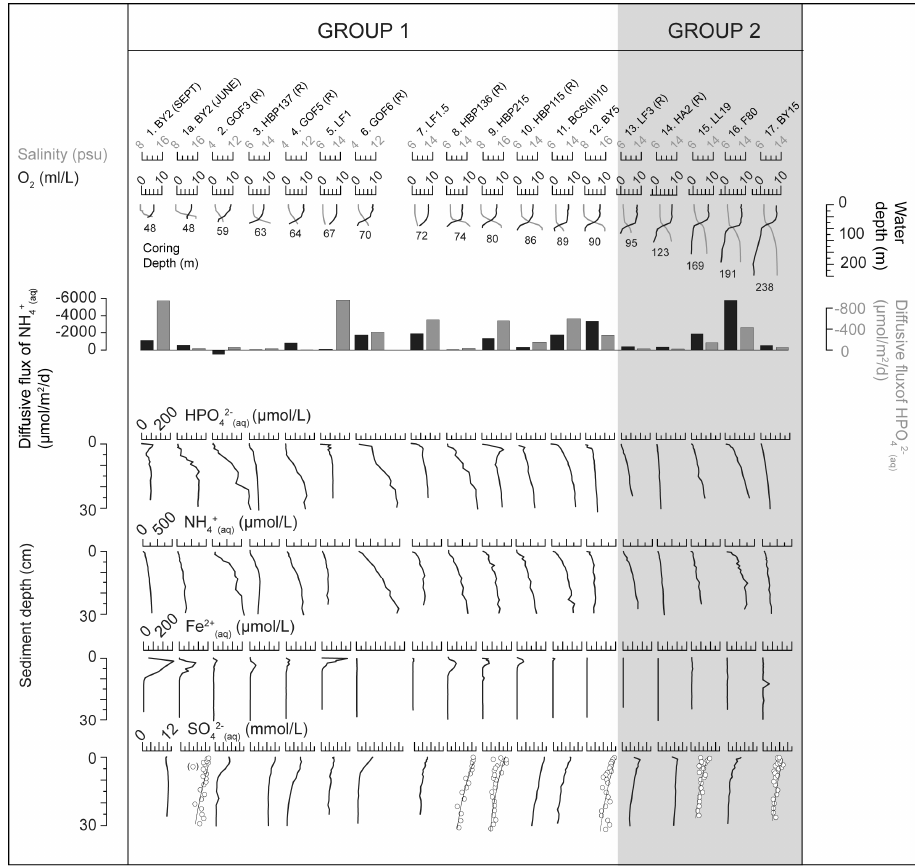
Figure 2. Data array of sites used in this study, arranged by increasing water depth from left to right. Upper panel: Water column salinity and oxygen profiles. All profiles were measured during the HYPER/COMBINE cruise of the R/V Aranda in May/June 2009, except site 1. BY2 (Sept), for which profiles were measured during a cruise with the R/V Skagerak in September 2007 (Mort et al., 2010). Sub-zero oxygen concentrations are estimated from hydrogen sulfide concentrations using the ratio 1 mol H 2 S = 2mol O 2 (see Fonselius, 1981). Middle panel: Diffusive fluxes of NH + and HPO − across the sediment-water interface, calculated from the concentration gradient between bottom 4 4 water and the uppermost porewater sample (0–0.5cm depth for cores sliced for porewater extraction by centrifugation, 0–1cm depth for cores sample with rhizons, indicated “R”) using Fick’s first law: ϕ · D ∂C F =− ∂z θ 2 where F = flux in µmolm − 2 day − 1 , and minus sign indicates an efflux from the sediments, D = ion-specific diffusion coefficient, corrected for temperature, taken from Boudreau (1997) and adjusted for salinity according to Van Cappellen and Wang (1995), φ = porosity and θ = tortuosity, defined as per Boudreau (1997): (cid:16) (cid:17) θ 2 = 1 − ln ϕ 2 Lower panel: Porewater profiles of HPO − , NH + , Fe 2 + and SO 2 − . See text for details of sampling resolution and processing. SO 2 − 4 4 4 for six sites are presented as logarithmic best-fit lines through raw data due to high scatter (data point in brackets for BY2 (June) not included in fit). All other profiles represent raw data